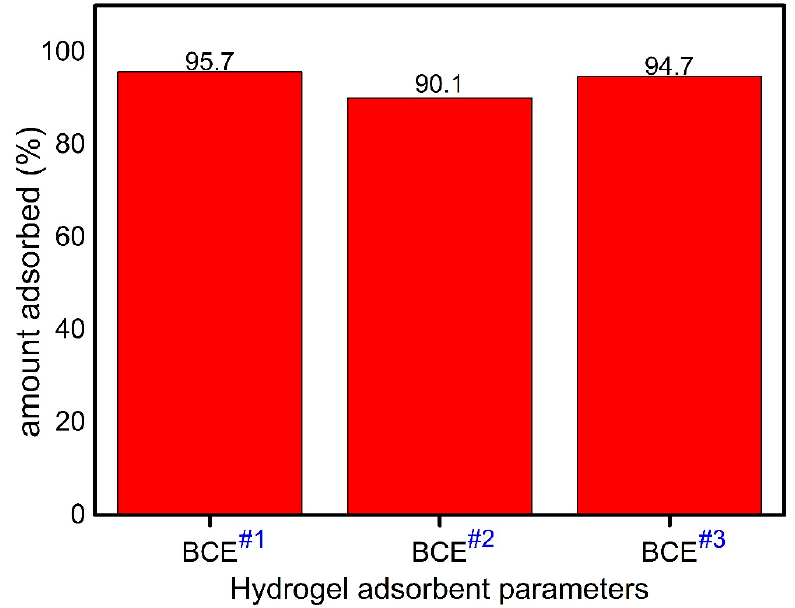
Figure 5. Bismuth adsorption from non-competitive aqueous solution.